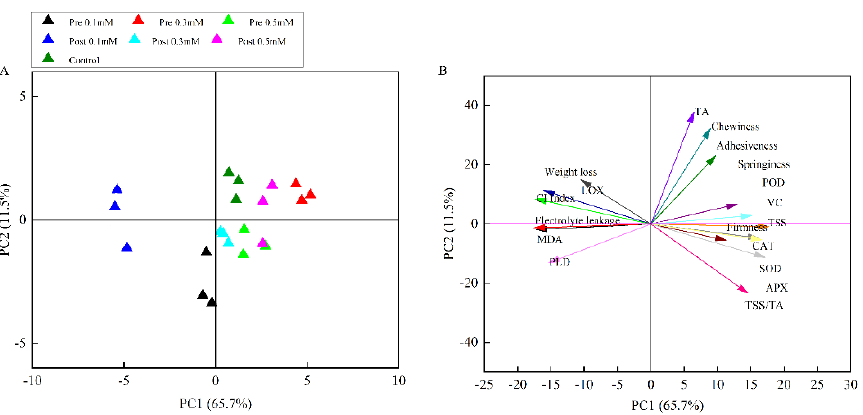
Figure 7. Principle component analysis (PCA) of 17 important indexes measured at the last sampling date of the lemons. ( A ) Score plot of PC2 against PC1; ( B ) Load plot of PC2 against PC1.